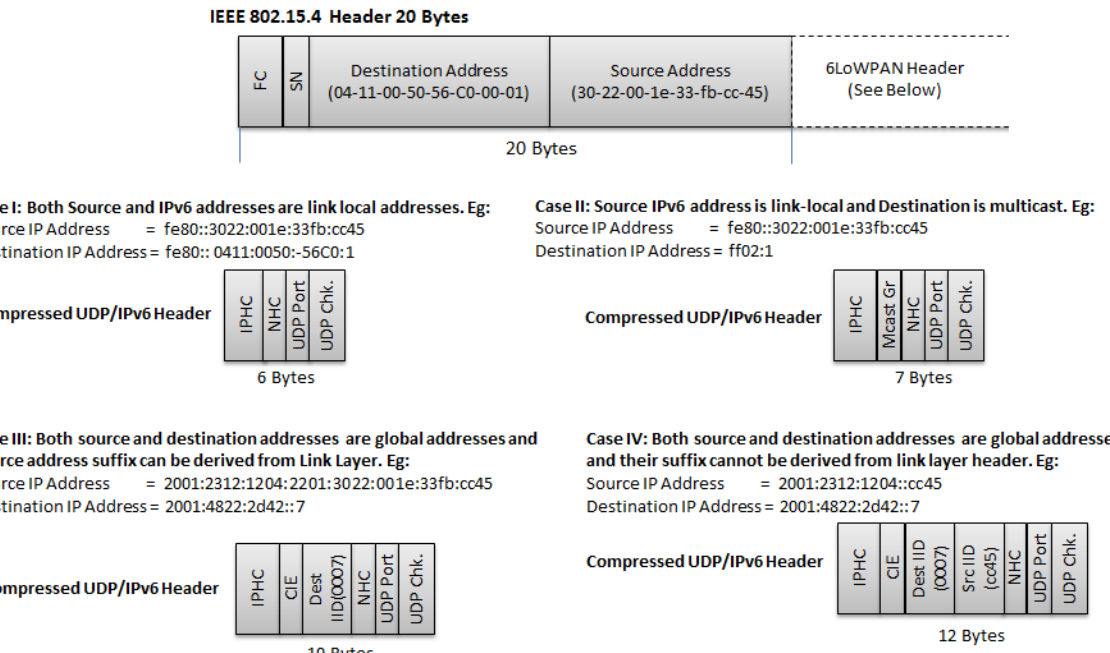
Figure 6. Internet Protocol Version 6 (IPv6) Header Compression